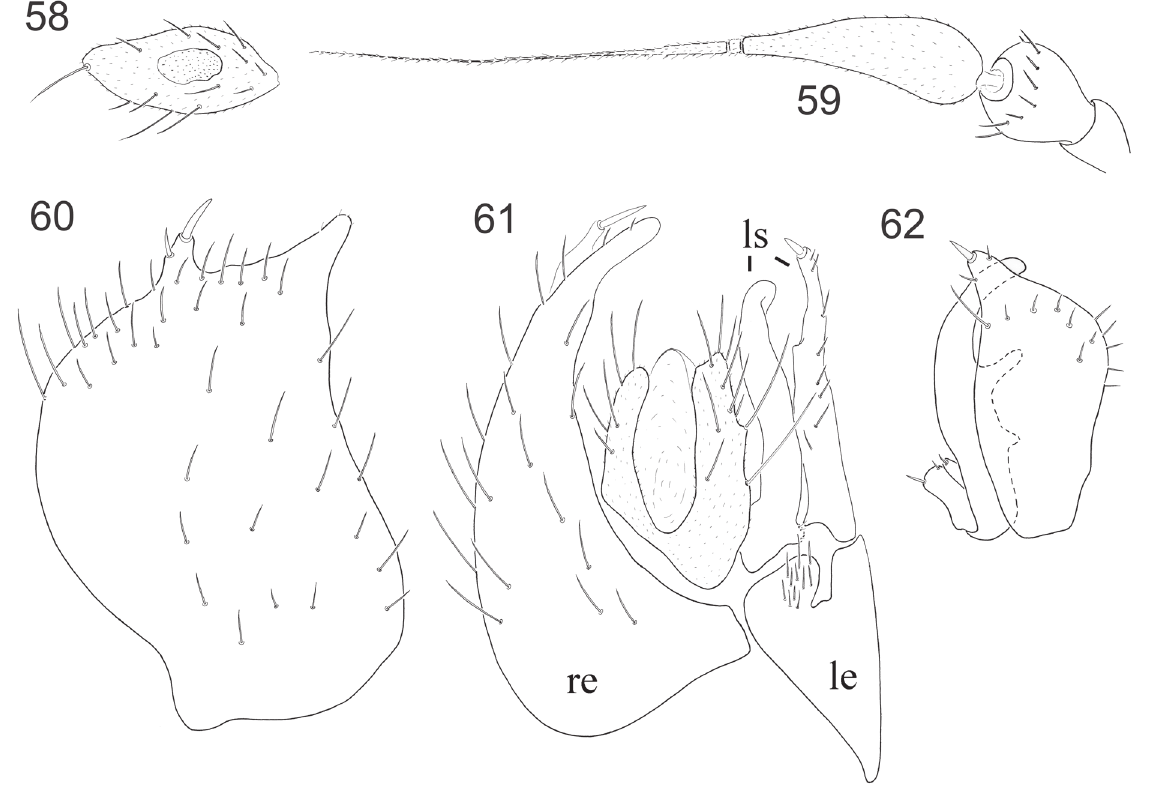
Figs 58-62. Chersodromia nigripennis Shamshev & Grootaert, 2005, ♂. 58 . palpus, lateral view. 59 . antenna, lateral view. 60 . right epandrial lamella, lateral view. 61 . epandrium and cerci, dorsal view. 62 . left surstylus, lateral view. (after Shamshev & Grootaert